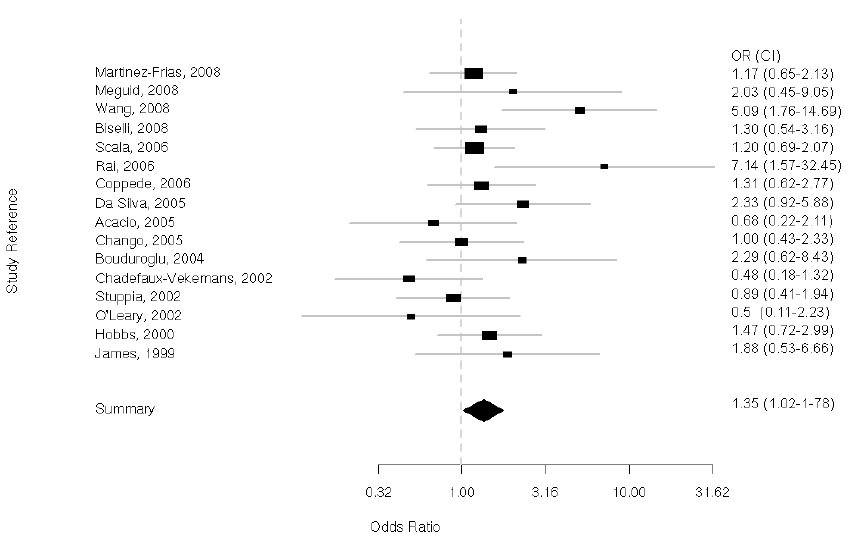
Figure 1. Results of individual and summary odds ratio estimates with 95% CI (random effect model): MTHFR/C677T polymorphism – recessive genetic